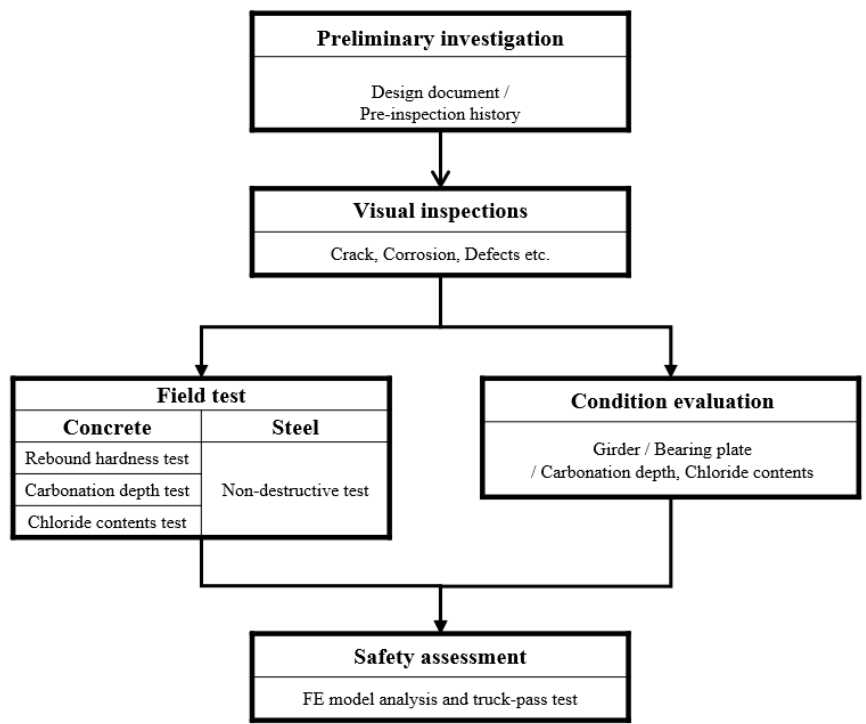
Figure 1. Procedure of determining load-carrying capacity.